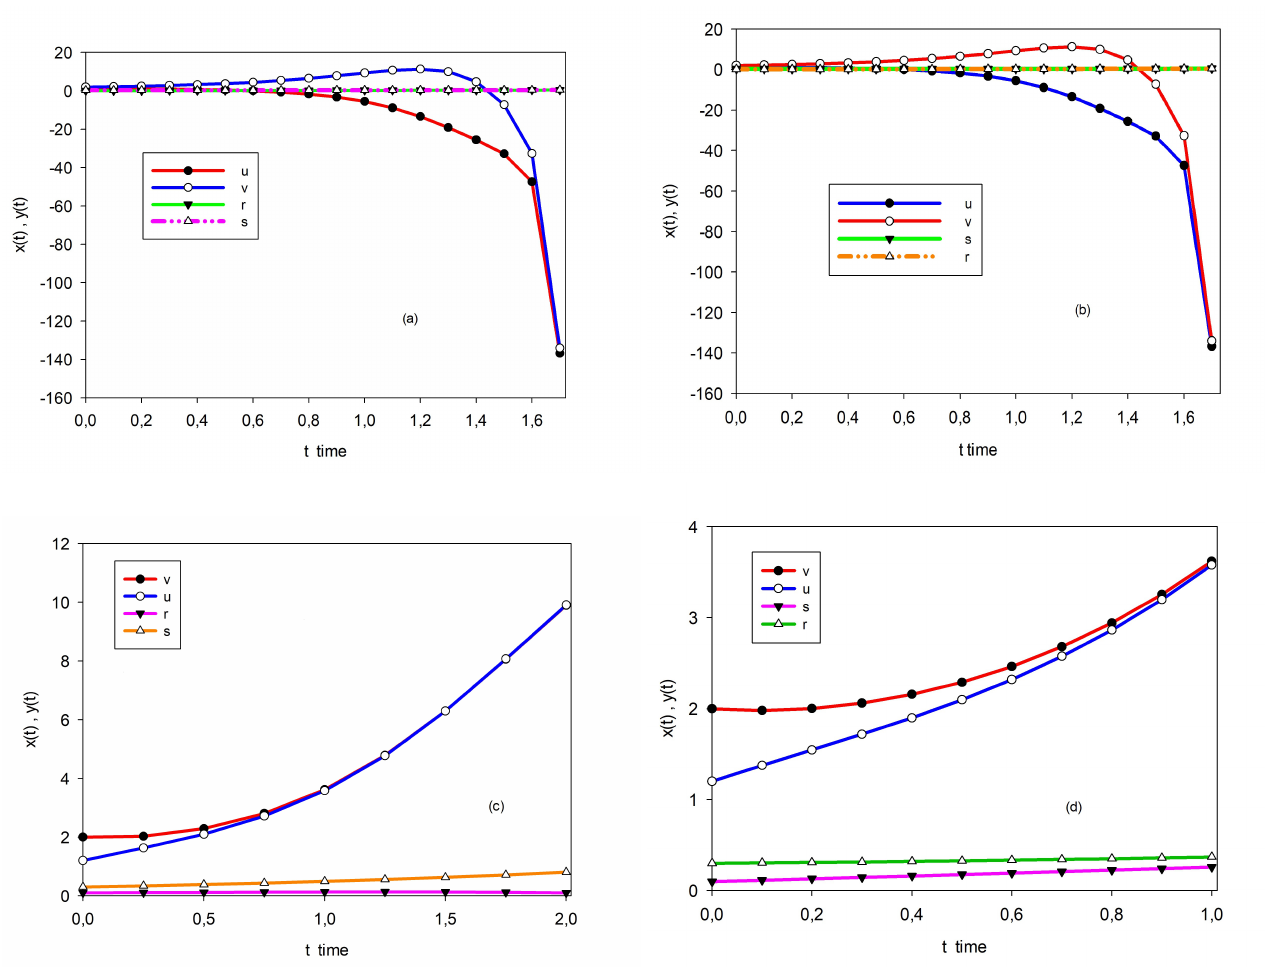
Fig. 2 Fuzzy solution of (4) for α =